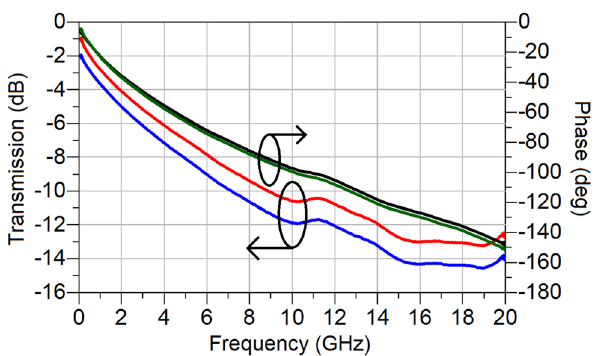
Figure 11. Extracted transmission coefficients of amorphous NiO; red (OFF state, magnitude), blue (ON state 12 V, magnitude), black (OFF state, phase) and green (ON state 12 V,